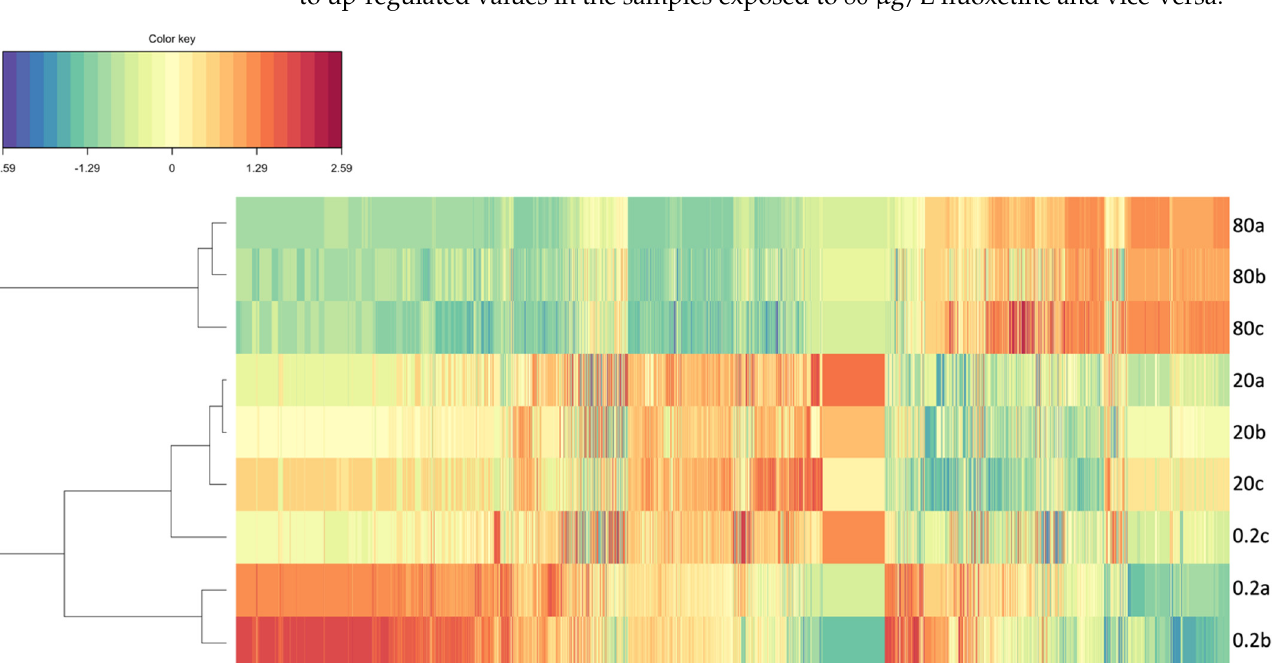
Figure 6. Mass intensity fold-change Variable Importance in Projection Partial Least-Squares Discri- minant Analysis (VIP-PLS-DA) biplot ( A ) and a scatterplot of the attained VIP scores and correlation coefficients (R 2 ) and significance classes (P) between the calculated fold-change and the fluoxetine exogenous dose applied ( B ), for the detected mass values with VIP score values above 1.